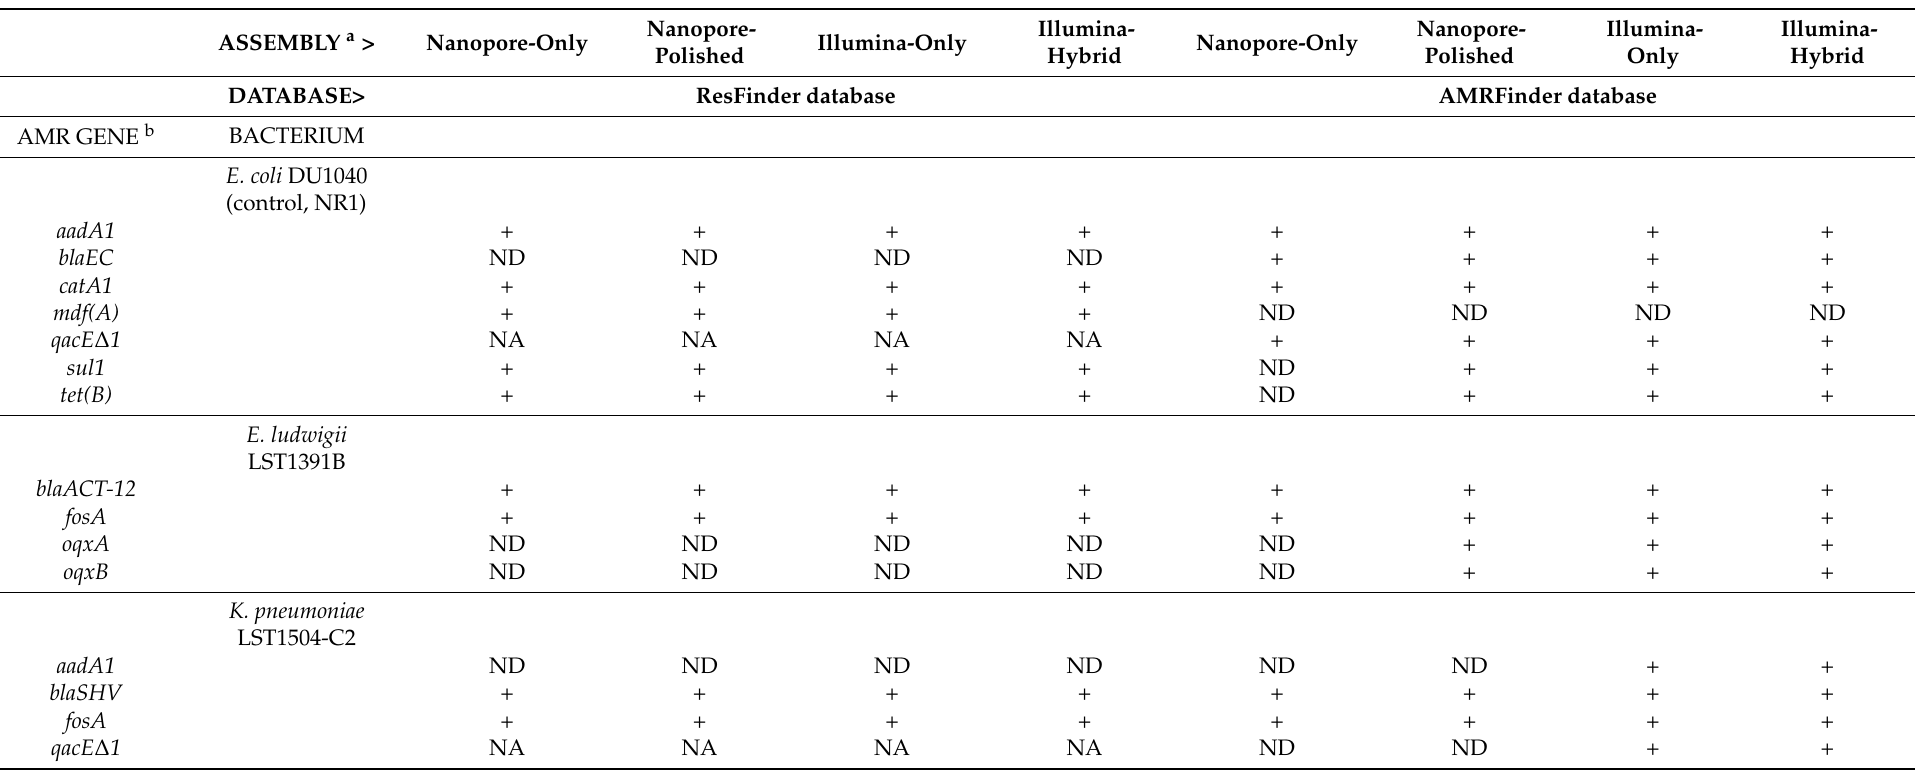
Table 5. Comparison of two sequencing chemistries, four assembly pipelines, and two databases for the detection of antimicrobial resistance (AMR) genes in the total genomic